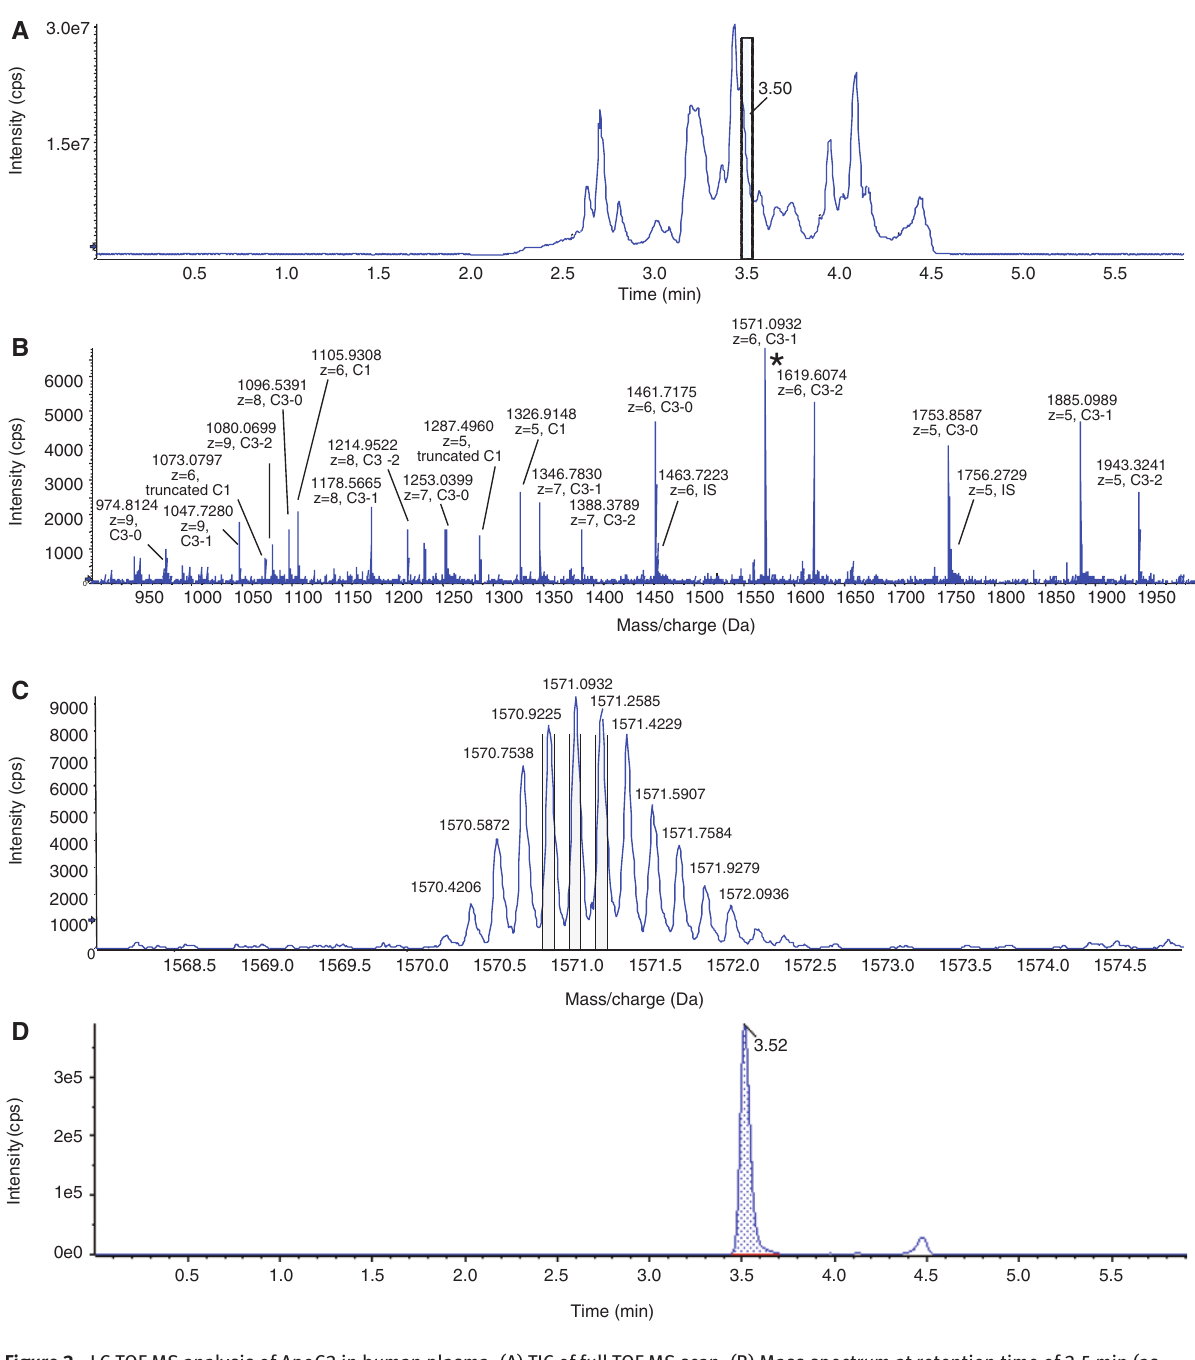
Figure 3 LC-TOF MS analysis of ApoC3 in human plasma. (A) TIC of full TOF MS scan. (B) Mass spectrum at retention time of 3.5 min (as selected in A). (C) Enlarged spectrum of ApoC3-1 at charge state 6 (as indicated by * in B). The extraction window for peak integration was shown by the shade. (D) Chromatographic peak of ApoC3-1 by integrating three most abundant isotopic peaks at each of charge state 5 and 6 (reproduced from Jian et al. 2013, with